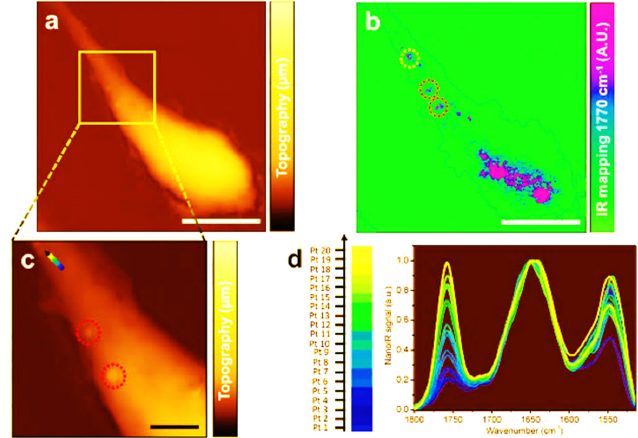
Figure 10. Unlabeled imaging of Polylactic acid (PLA) NPs in a cell analyzed by ATM-IR. ( a ) AFM topography of a THP-1 macrophage (color grading = 0–3 µm). ( b ) IR map of the cell at 1770 cm − 1 . The selected zone (dashed yellow circle) includes several PLA NPs (color grading = 0–100 A.U.). ( c ) Zoomed AFM topography showing two intracellular compartments containing NPs (red dashed circles ( b , c )). The multicolor arrow represents a row of spectra acquired with a 50 nm step, ( d ) IR spectra acquired along this line. Ref [114] Reproduced with permission from Pancani et al., Part. Part. Syst. Charact.; published by Wiley-VCH, 2018.